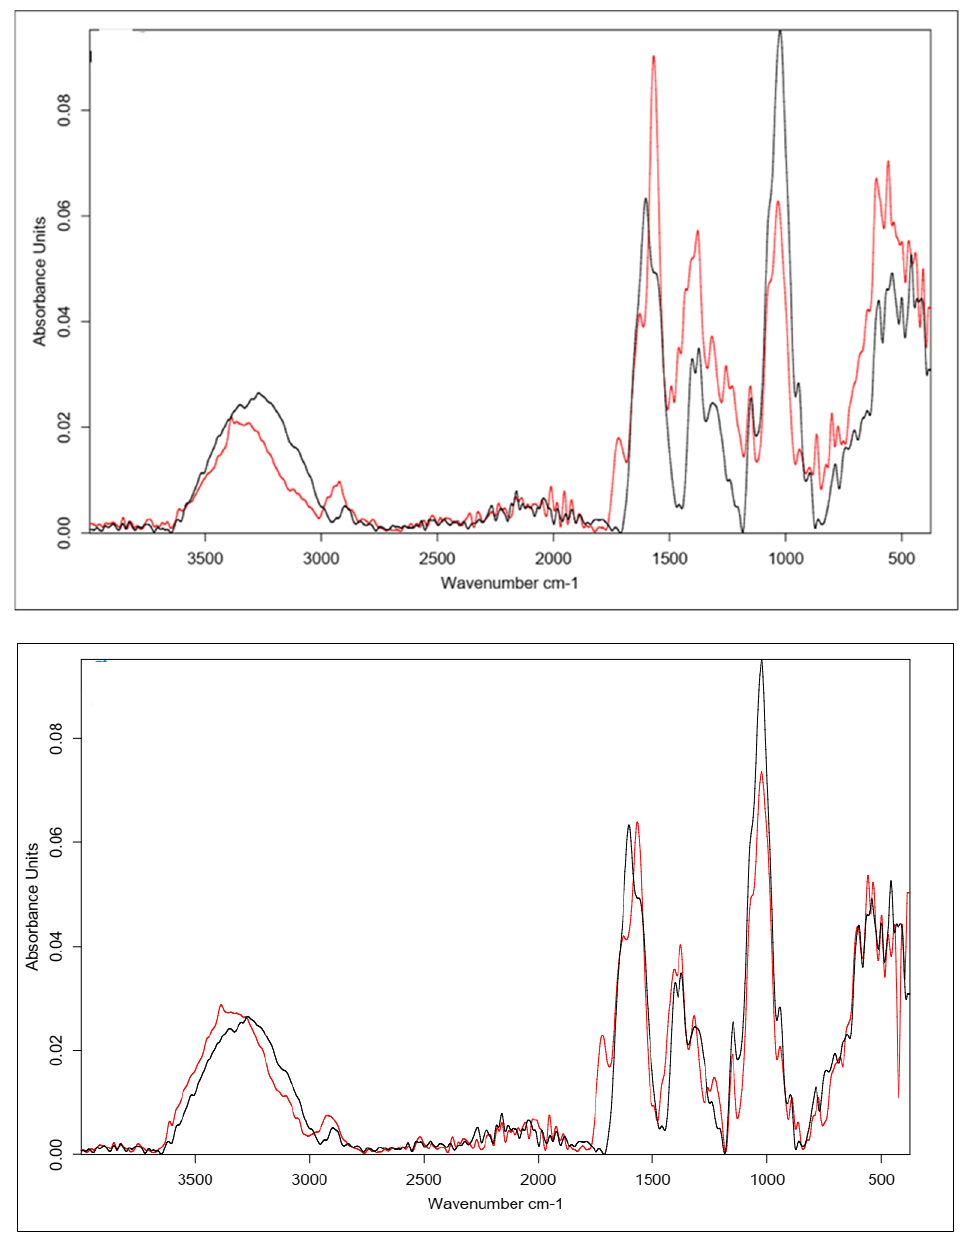
Figure 8. FT-IR spectra of the HA cross-linked with CA via both procedures (Procedure I—top one; Procedure II—bottom one). FT-IR spectrum of native HA (black) vs. HA cross-linked with 25% citric acid via Procedure I (top, red) and 20% citric acid via Procedure II (bo tt om, red).